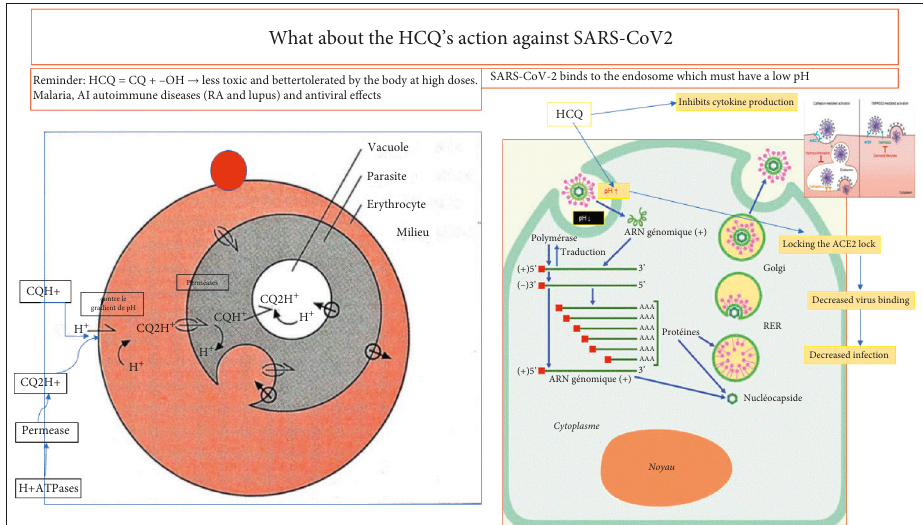
Figure 8: Comparison of HCQ actions in SARS-CoV-2 and Pf trophozoites (Sources: https://wikipedia.org and Futura-Sciences completed in this study).